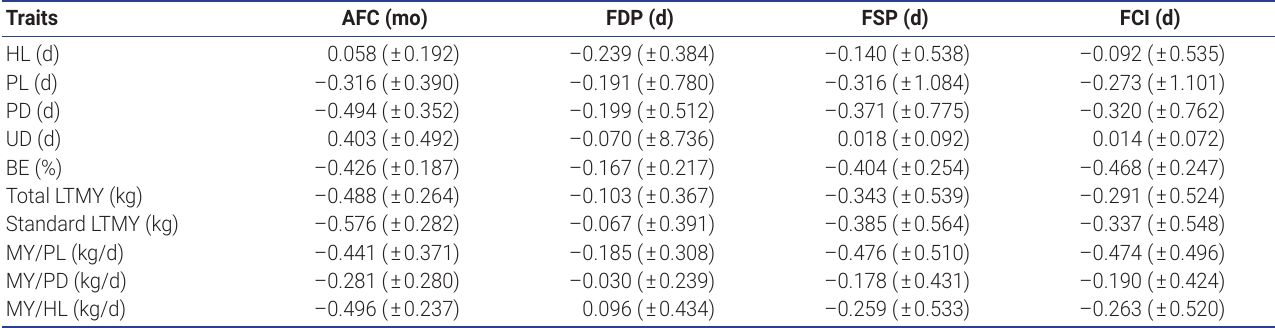
Table 6. Genetic correlation between first lactation reproduction and lifetime traits in Murrah buffaloes Traits